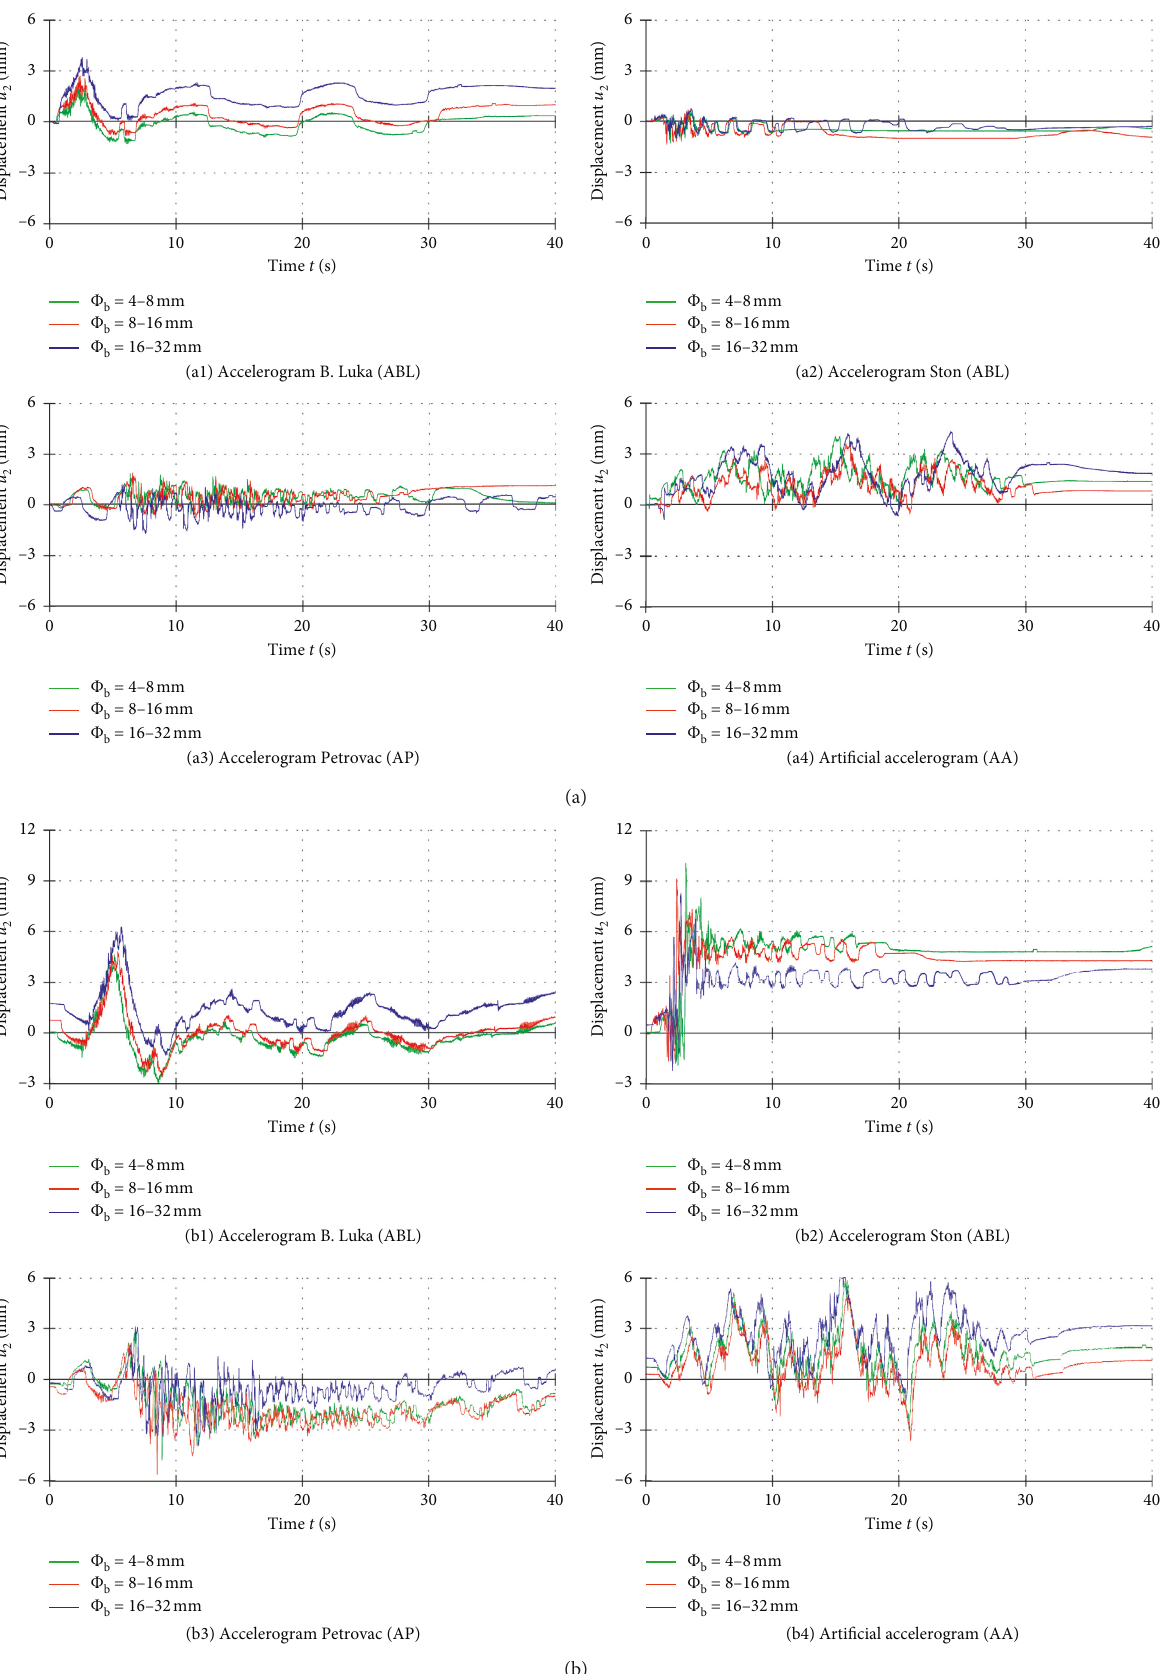
� 0.2 g. (b) PGA � 2 . (a) PGA